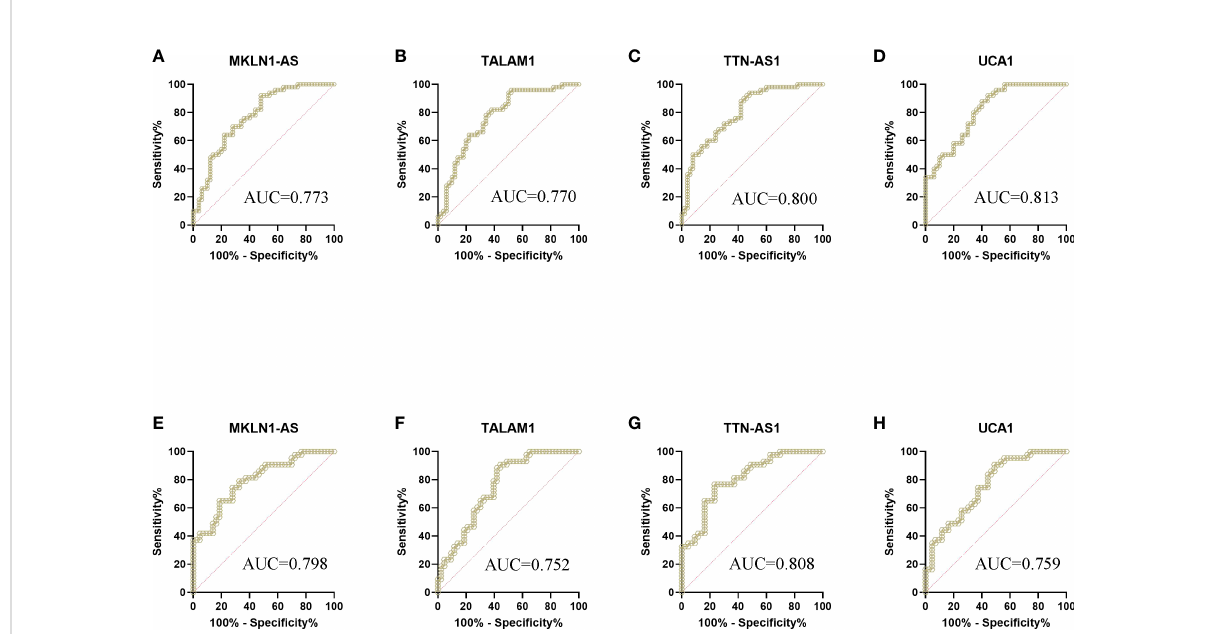
FIGURE 3 ROC curve analysis of lncRNAs for the diagnosis of bladder cancer from controls. (A) MKLN1 in the training cohort, AUC=0.773 (B) TALAM1 in the training cohort, AUC=0.770 (C) TTN-AS1 in the training cohort, AUC=0.800 (D) UCA1 in the training cohort, AUC=0.813 (E) MKLN1 in the validation cohort, AUC=0.798 (F) TALAM1 in the validation cohort, AUC=0.752 (G) TTN-AS1 in the validation cohort, AUC=0.808 (H) UCA1 in the validation cohort,